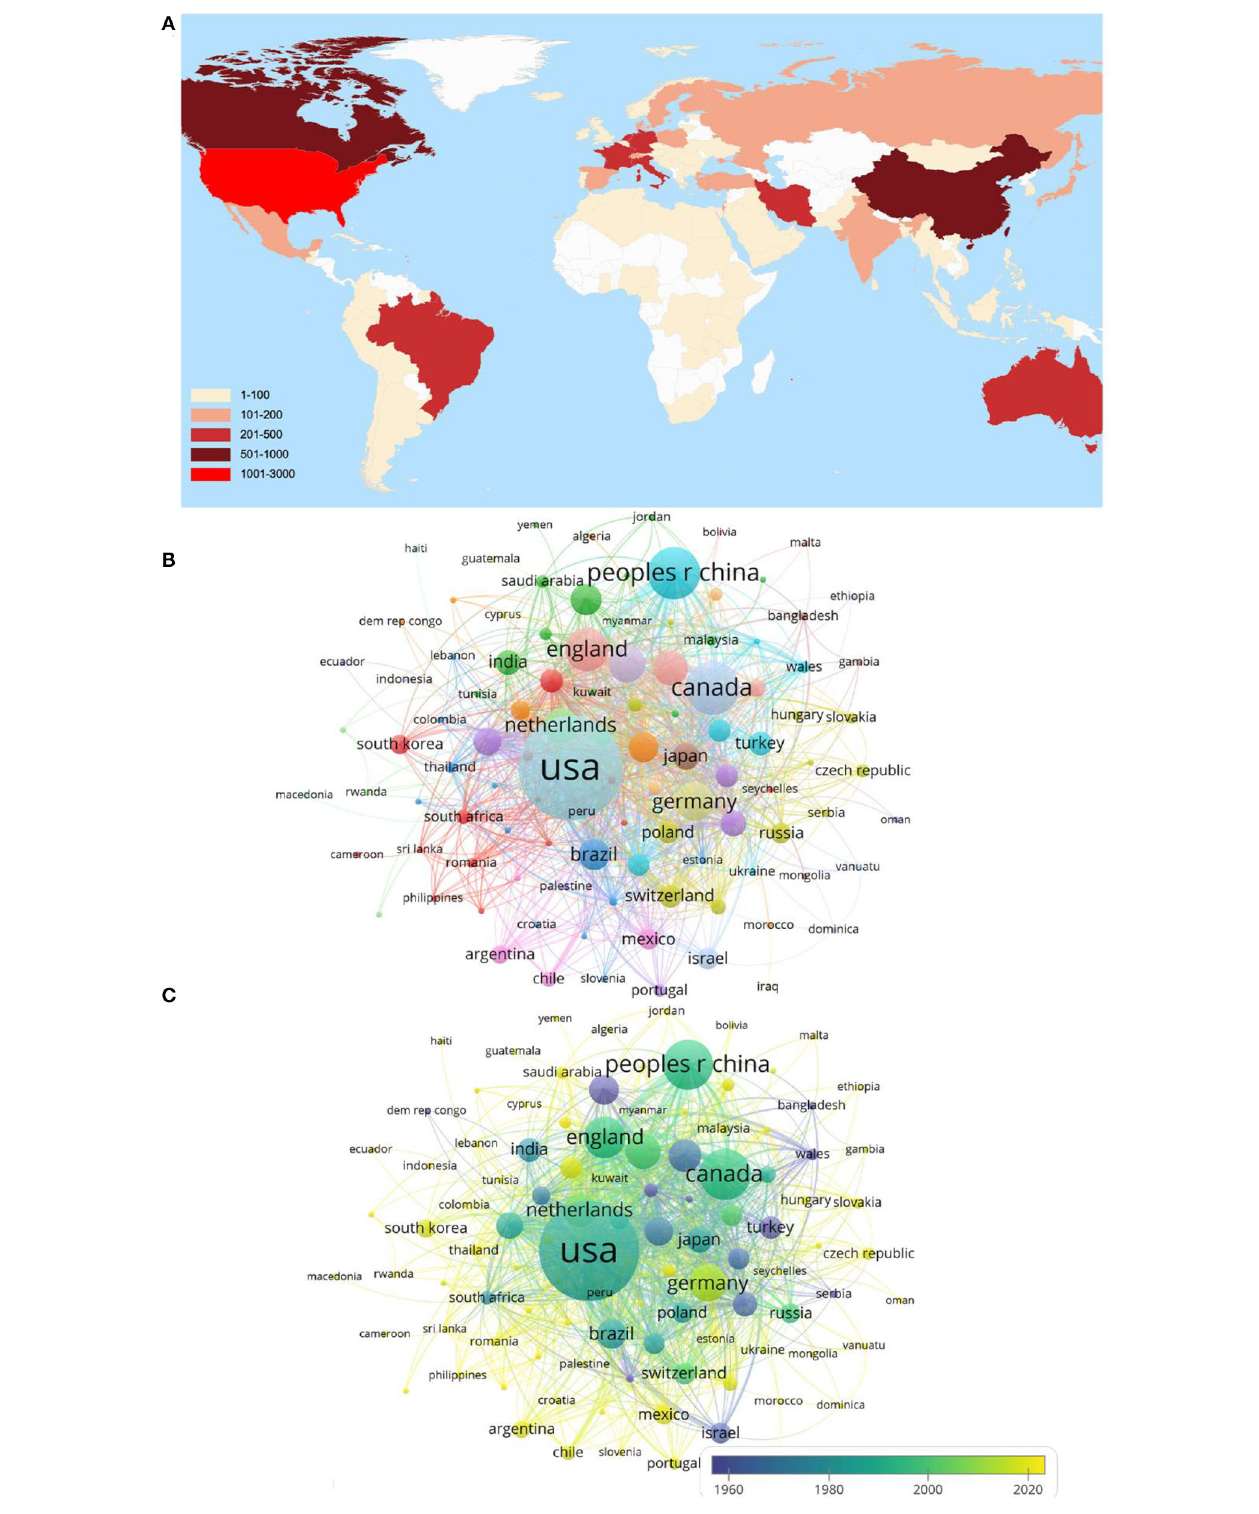
FIGURE 3 | Mapping of countries of studies related to PS. (A) Geographic distribution of PS-related research articles from 2011 to 2021. (B) Network of 110 countries. (C) Visualization of countries according to the APY. Countries in yellow published articles later than those in blue.